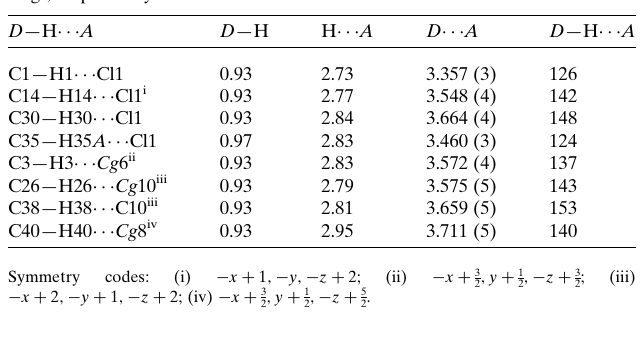
Table 2 Hydrogen-bond geometry (A˚ , (cid:4) ). Cg 6, Cg 8 and Cg 10 are the centroids of the C17–C22, C29–C34 and C42–C47 rings, respectively.